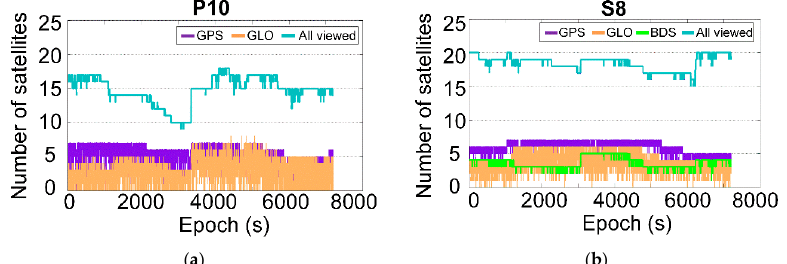
Figure 11. The number of satellites viewed in the positioning test of smartphone P10 ( a ) and smartphone S8 ( b ).